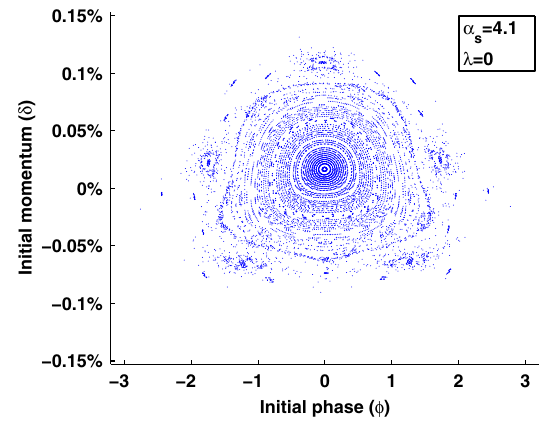
FIG. 7. Poincaré map for conventional slip stacking with a value of α s corresponding to 100 kV main rf voltage and 1260 Hz rf frequency